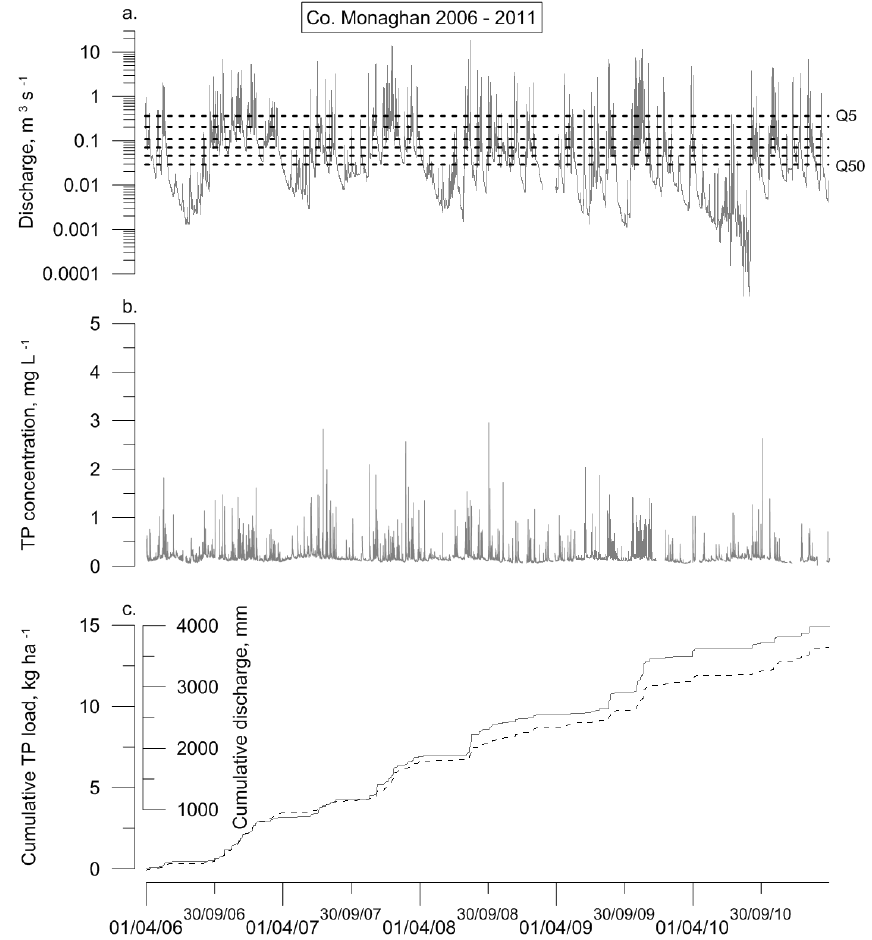
Figure 5. Time-series charts for discharge (a) , TP concentration (b) and cumulative TP load and cumulative discharge (solid line) (c) from 2006–2011 in the Co. Monaghan sub-catchment Discharge ranges ( Q 50 , Q 40 , Q 30 , Q 20 , Q 10 and Q 5 are shown on the discharge time series as dashed lines.